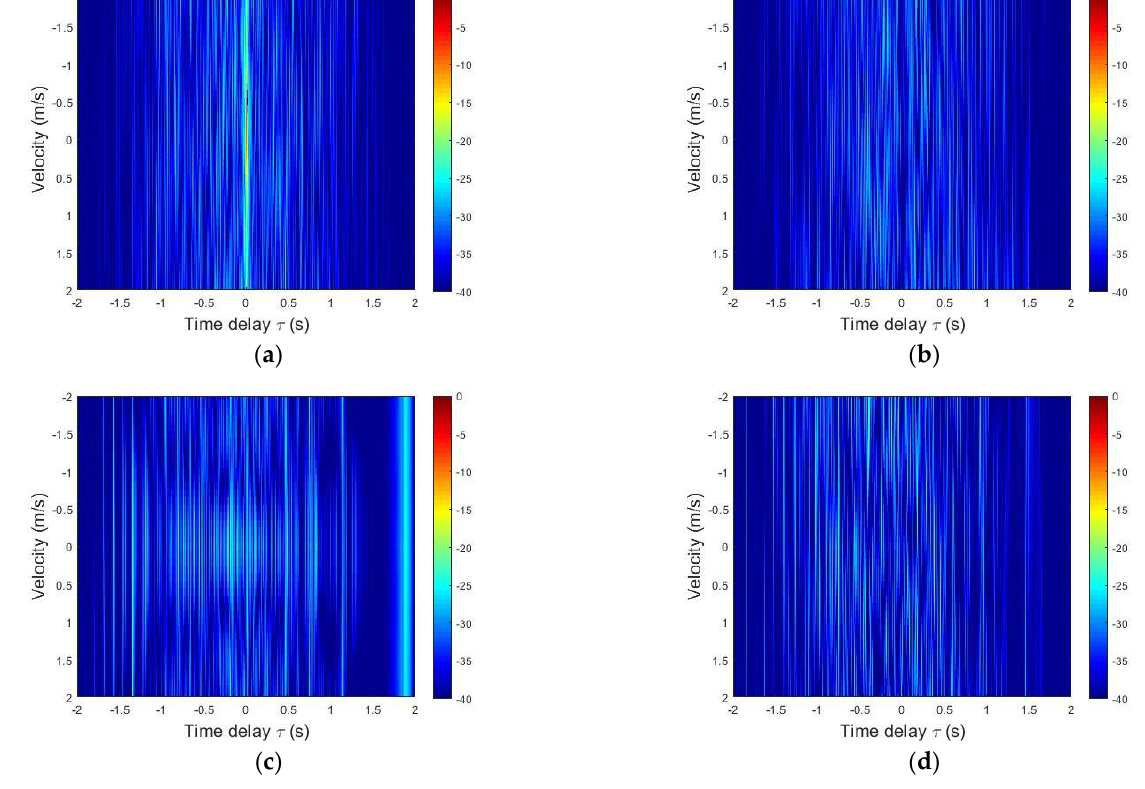
Figure 3. ( a ) Auto-AF of the FT, ( b ) cross-AF of the FT/FF and FT, ( c ) cross-AF of the RT and FT and ( d ) cross-AF of the RT/FF and FT.